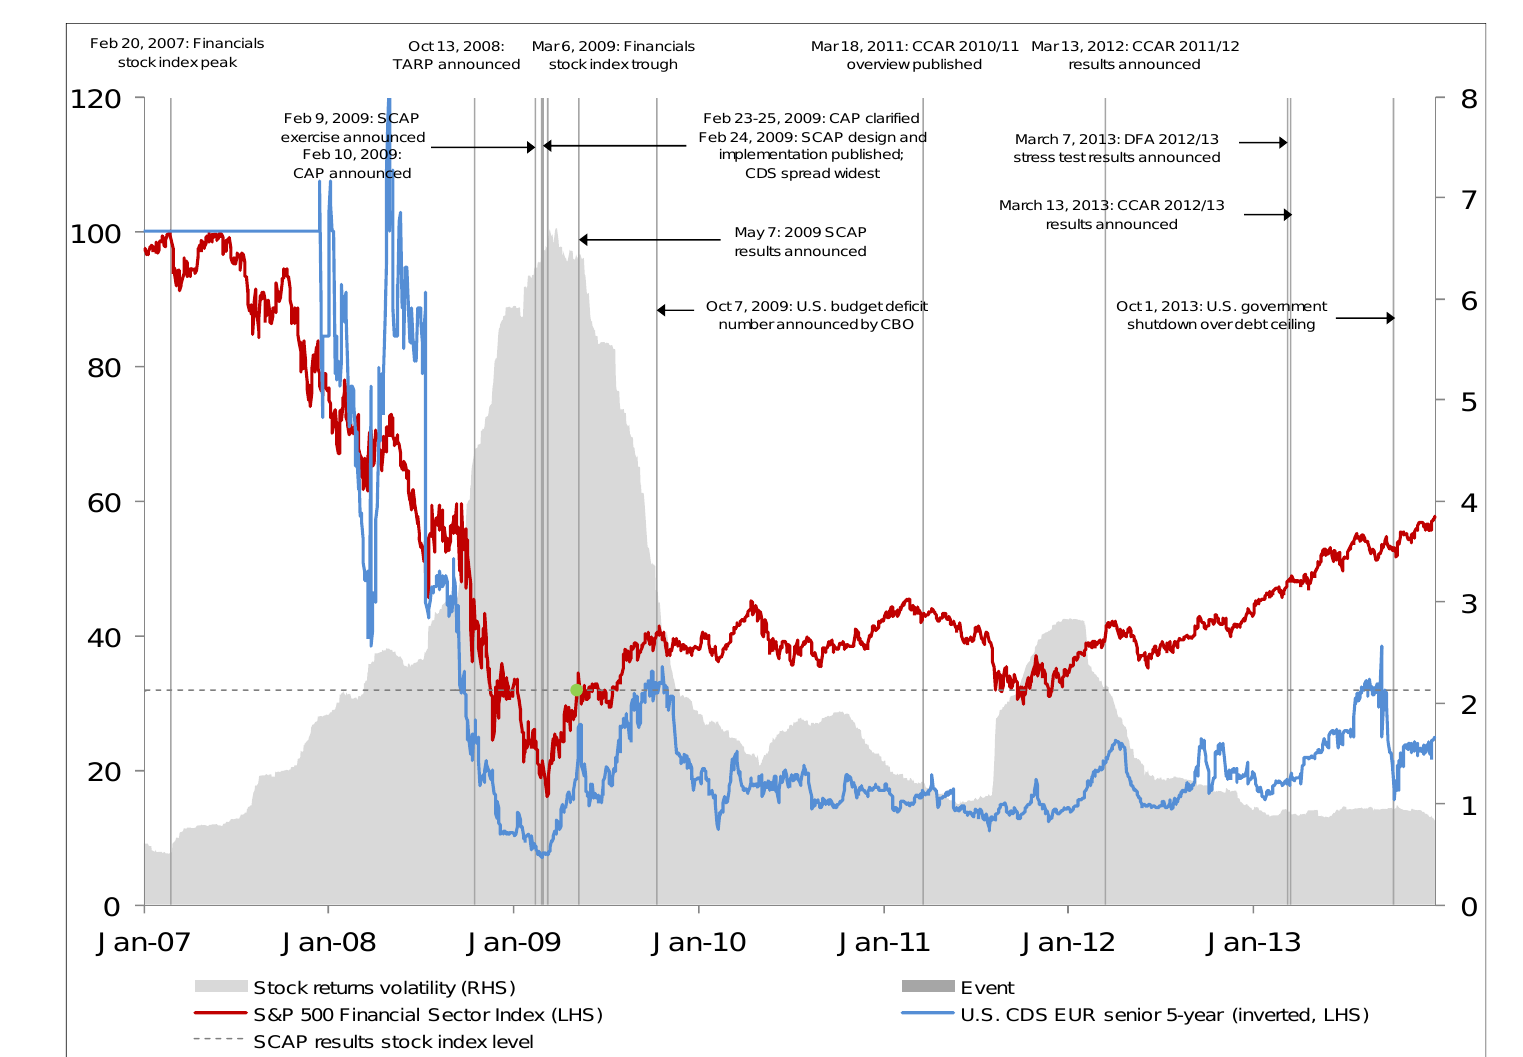
Figure 2. United States: The Sentiment after the SCAP (Indexed to 100 on 20 February 2007).